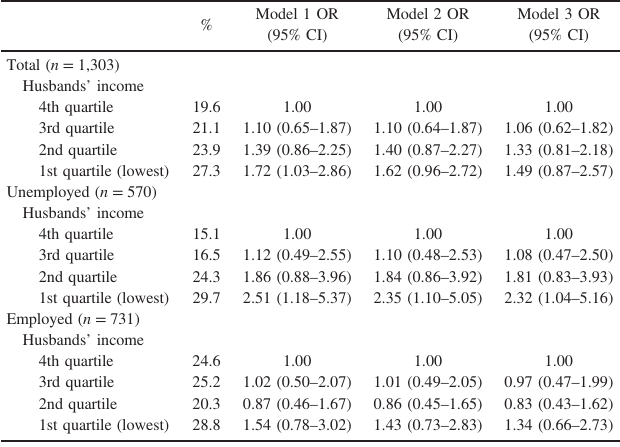
Table 5. Prevalence and odds ratios for poor oral health according to husbands ’ income among married women